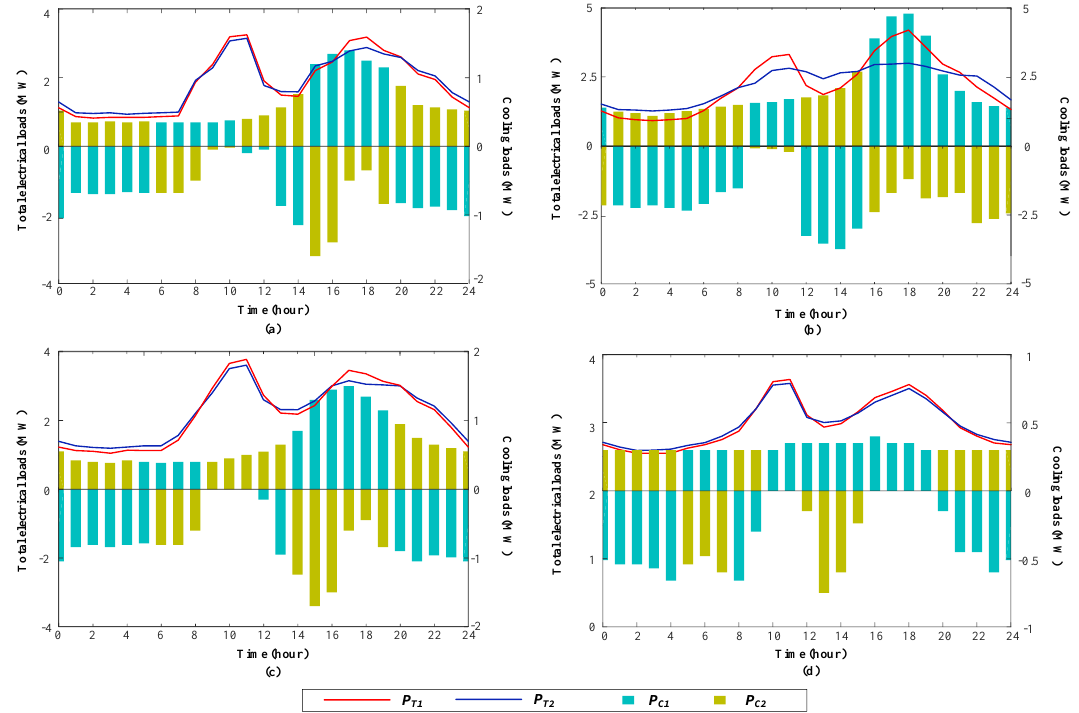
Figure 7. Optimal output of two ice storage devices and average daily electrical load curve of the integrated energy system in ( a ) spring; ( b ) summer; ( c ) autumn; ( d ) winter.